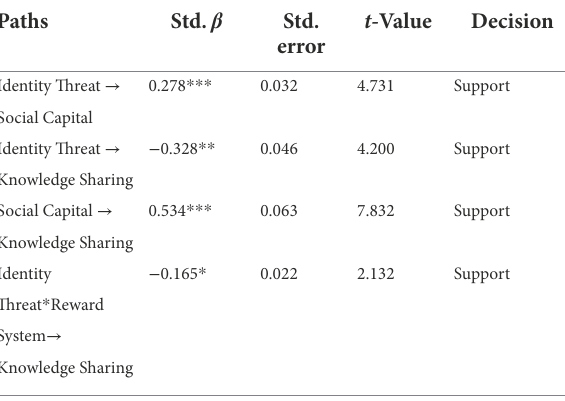
TABLE 2 Indirect effect of structural model. Paths Std.